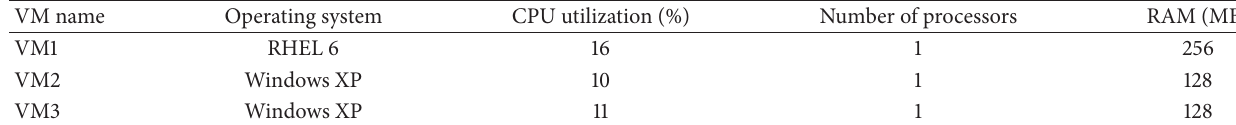
Table 13: Local list of node 4 (S1).